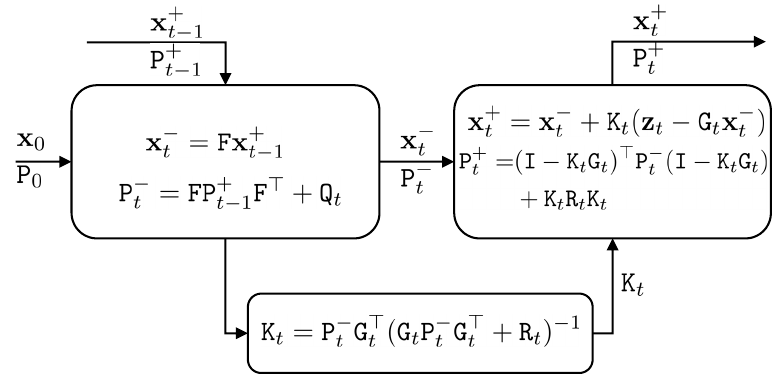
Figure 1. The Kalman filter procedure, which consists of prediction ( left-up box ) and update steps ( right-up box ). ( right-up box